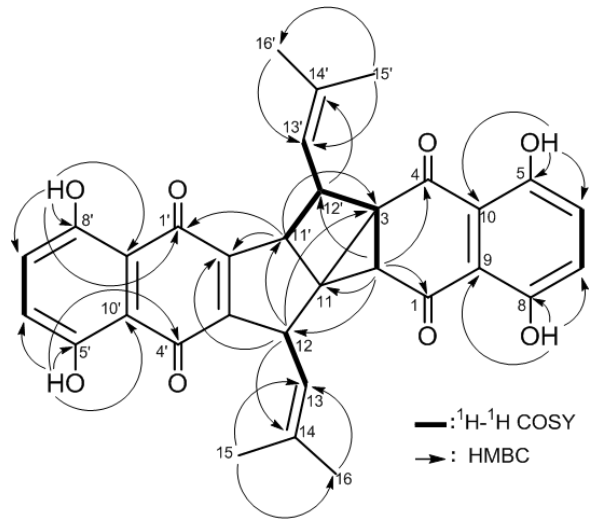
Figure 4. 1 H- 1 H COSY and HMBC correlations for 2